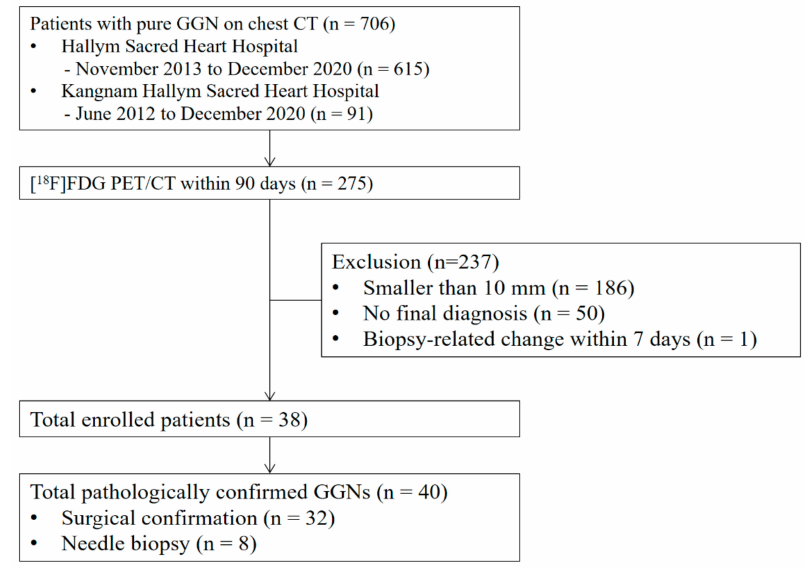
Figure 1. Flow diagram of patient